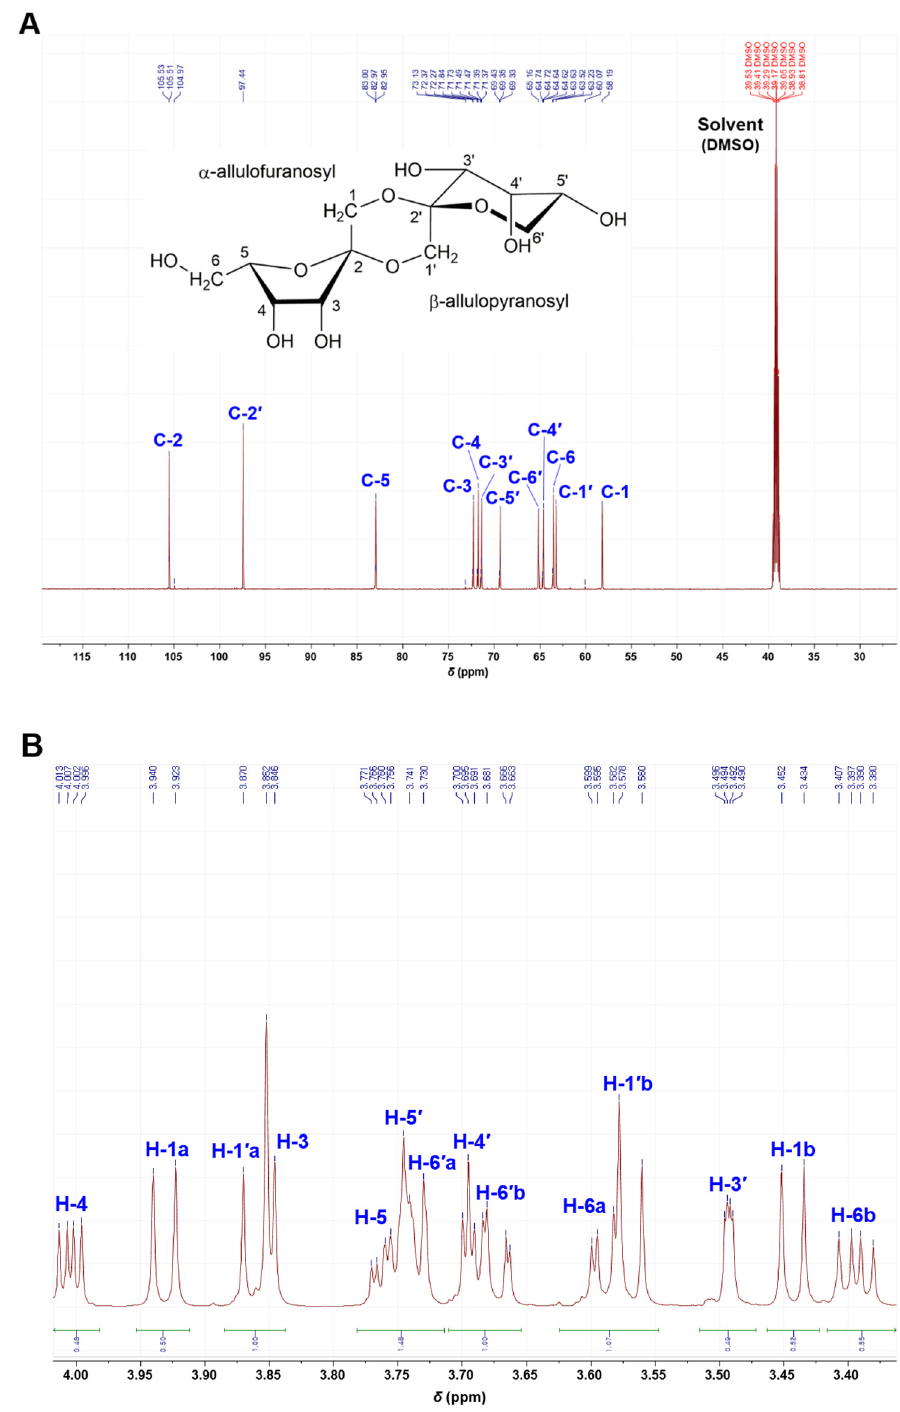
Figure 2. 13 C NMR spectrum ( A ) and 1 H NMR spectrum ( B ) of di- D -psicose anhydride. In the heteronuclear single quantum coherence (HSQC) spectrum (Figure 3), δ H 3.75 (1H, ddd, J = 7.7, 7.0, 2.8 Hz) of the cross peak with a C-5 signal was observed as an H-5 signal of α - D -psicofuranose (starting compound). The two-dimensional NMR spectra are shown in Figures S5 and S6. In the HSQC spectrum of the isolated compounds and the assignments of the 1 H NMR signals were unambiguously confirmed. In particular, the H- 6 ′ signal of ketohexose showed a unique coupling patterns, such as doublets of doublets and broad doublets. Several cross-peaks in the 1 H − 1 H correlation spectroscopy spectrum